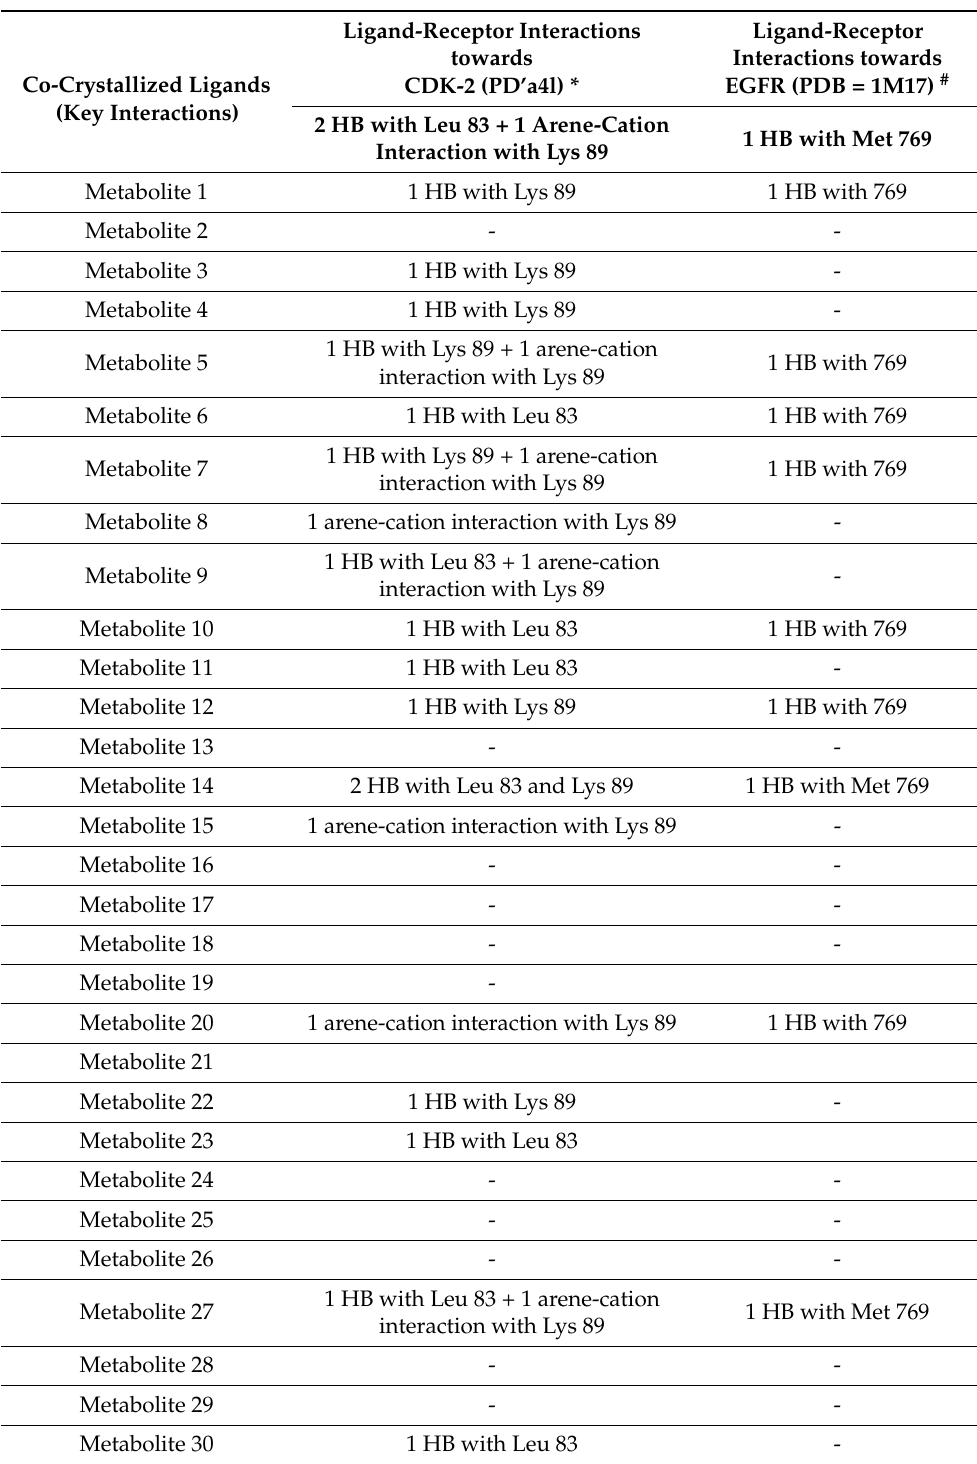
Table 5. Summary of ligand–receptor interactions of the identified docked compounds towards cyclin- dependent kinase (CDK2) and Epidermal growth factor receptor (EGFR) binding sites. * p ≤ 0.05; # , p ≤